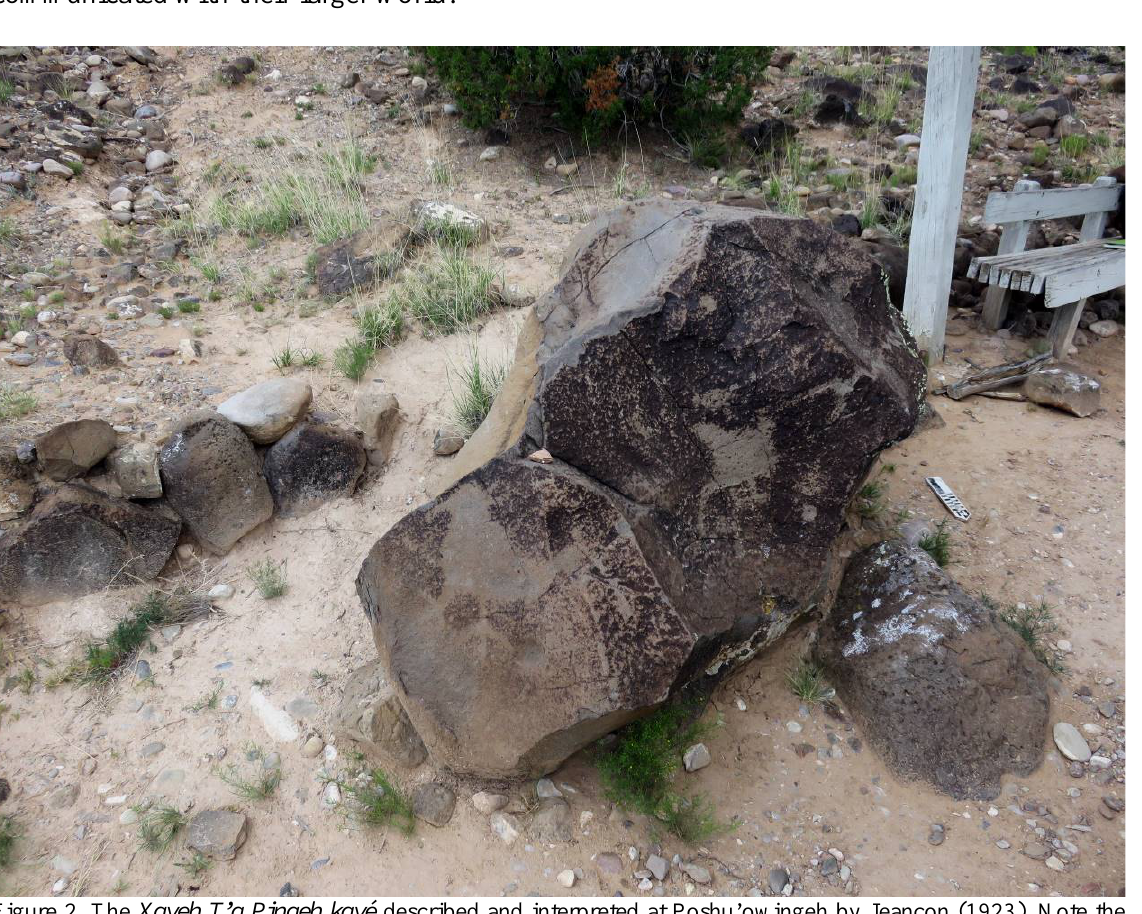
Figure 2. The Xayeh T’a Pingeh kayé described and interpreted at Poshu’owingeh by Jeançon (1923). Note the cupules below the bird petroglyph in the